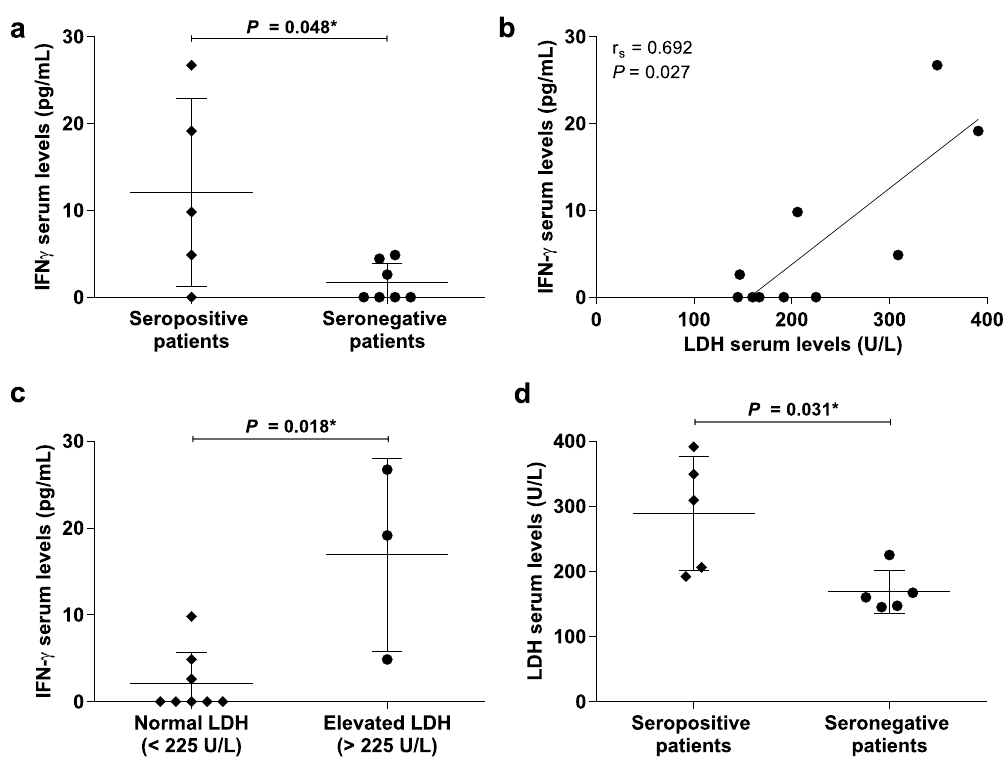
Figure 3. Association between LDH enzyme as muscle damage marker and immunological profile (autoantibodies and cytokines) of IIM patients. ( a ) Higher serum levels of IFN-γ in MSA/MAA seropositive patients; ( b ) higher serum levels of LDH in MSA/MAA seropositive patients; ( c ) correlation between IFN-γ and LDH serum levels, and; ( d ) higher serum levels of IFN-γ in patients with elevated levels of LDH. LDH Lactate Dehydrogenase; IIM Idiopathic Inflammatory Myopathies; IFN interferon; MSA Myositis Specific Autoantibodies; MAA Myositis Associated Autoantibodies.*Mann-Whitney U test with Fisher’s Exact